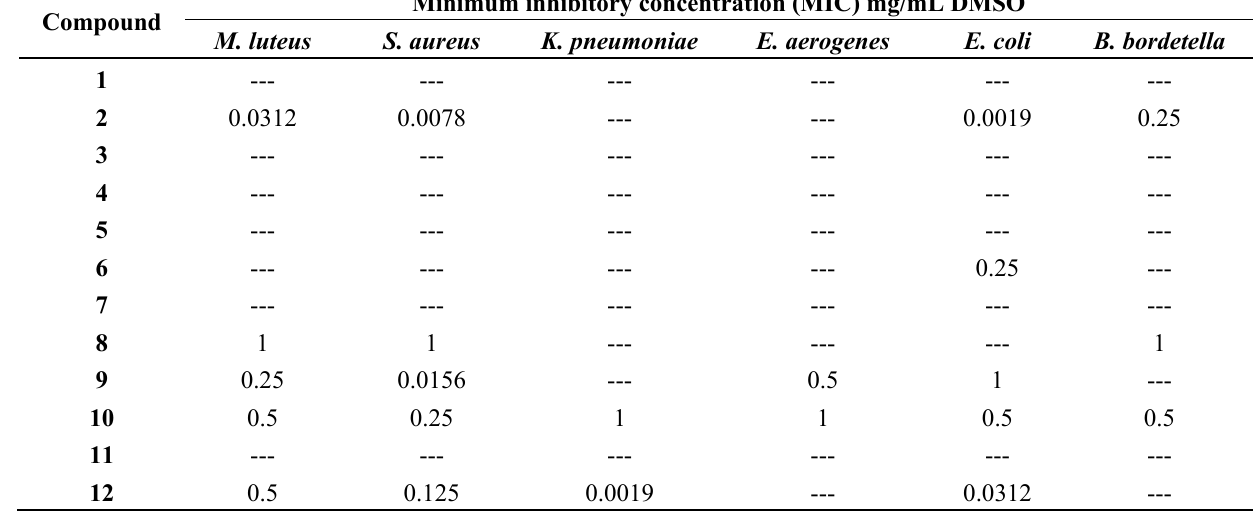
Table 7. Effective Minimum Inhibition Concentration (MIC) of synthesized guanidines against different bacterial